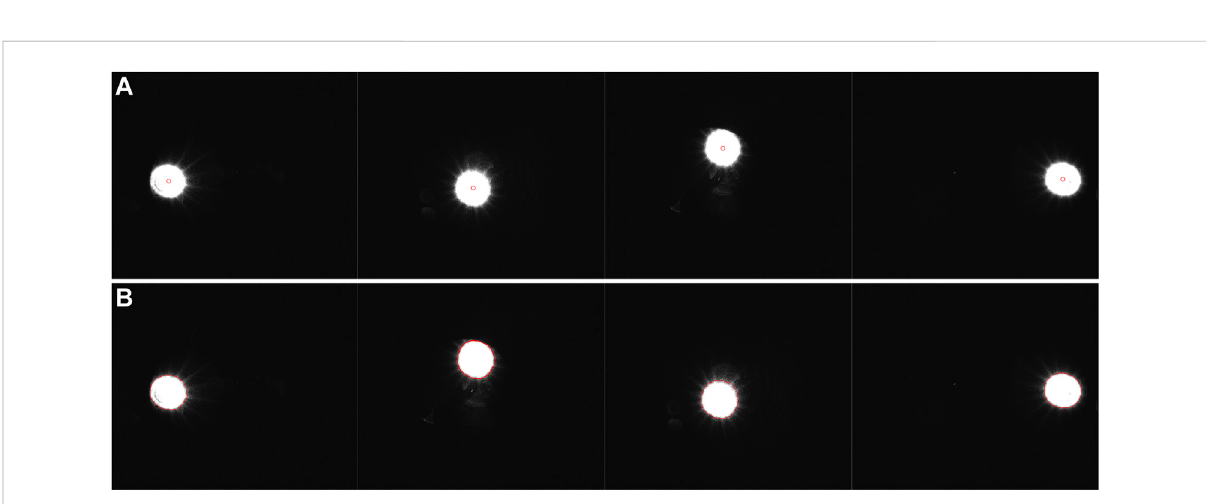
FIGURE 4 Adaptive initial curvecoordinatesand evolutionary results. (A) : Images of laser spotat differentpositions; (B) :Fitting results oflaser spot images at different